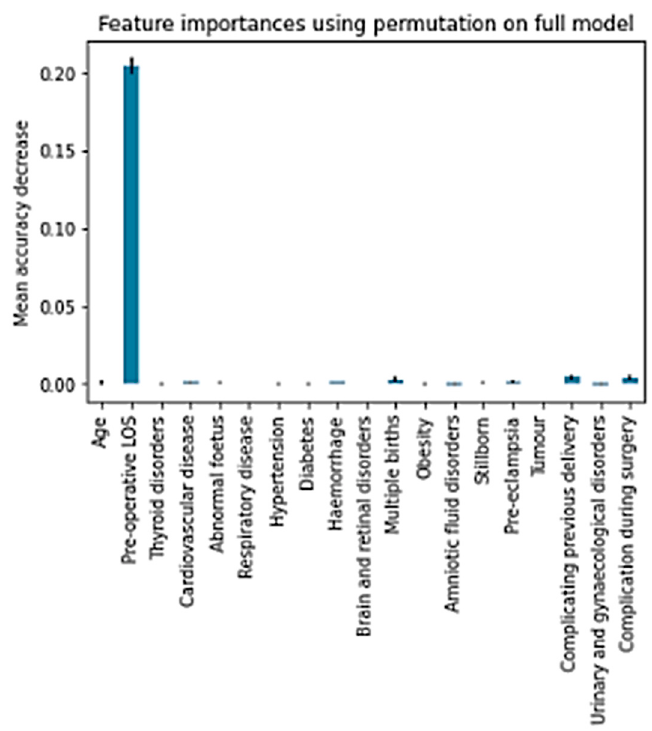
Table 8. NN Model summary.